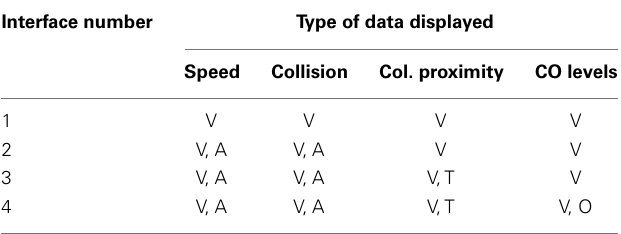
Table 6 |The four interface treatments for study #4 .